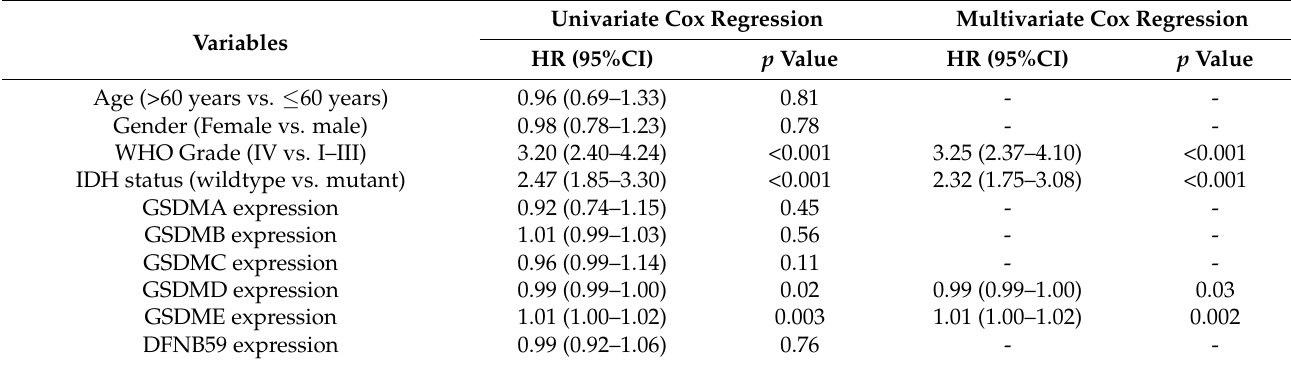
Table 2. Univariate analysis and multivariate COX analysis of clinical prognostic parameters of all glioma in the CGGA